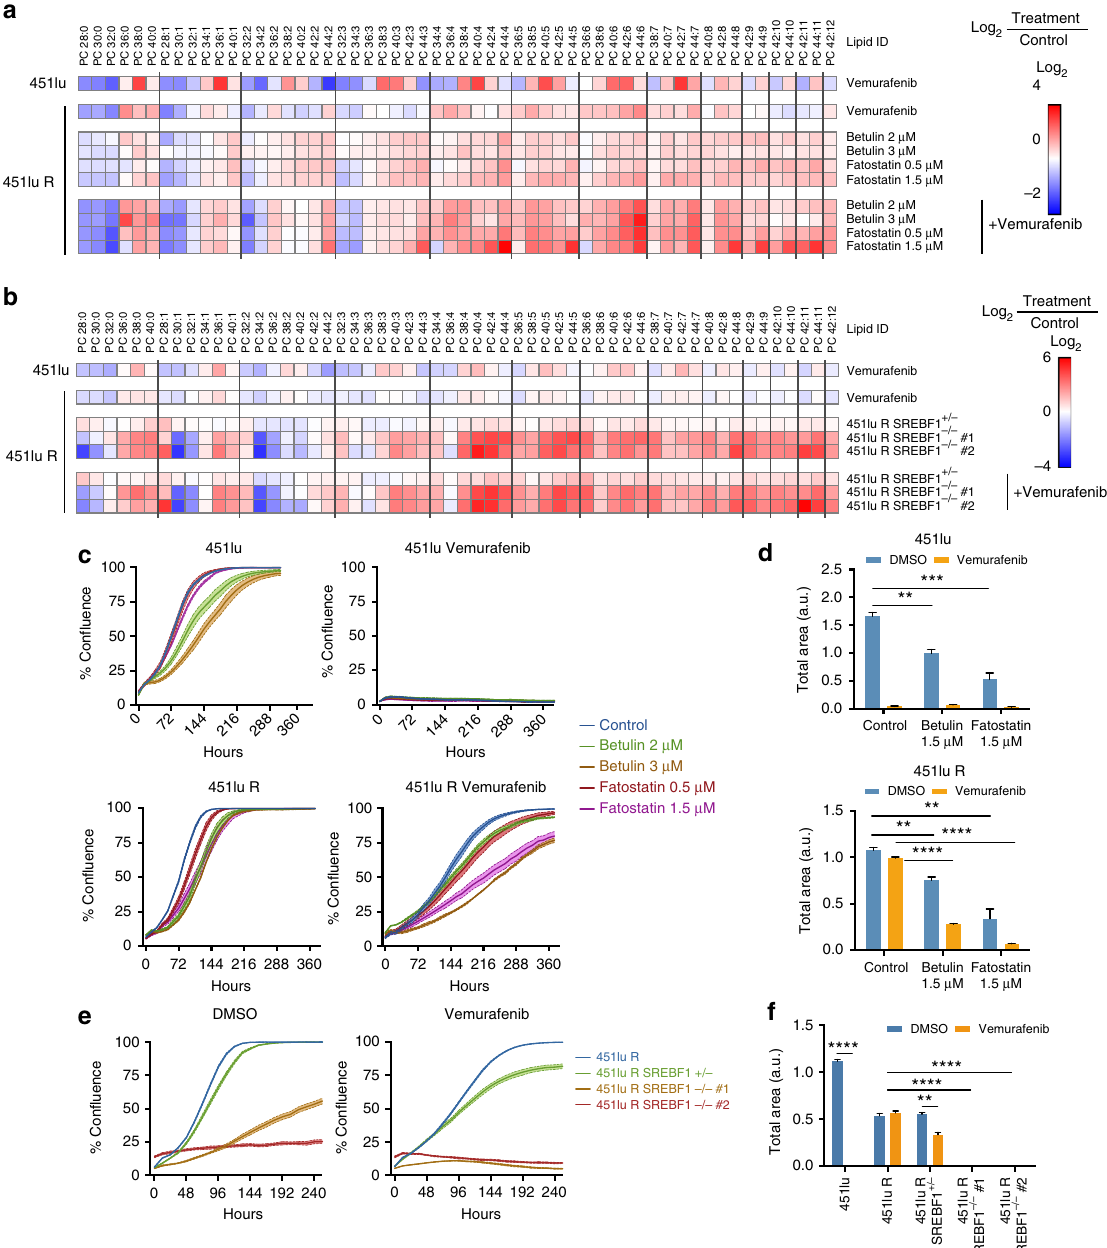
Fig. 3 SREBP-1 contributes to membrane saturation and therapy resistance. a Lipidomic (phosphatidylcholine) pro fi les of 451lu and 451lu R cells treated with vemurafenib (5 μ M) and SREBP inhibitors fatostatin and betulin ( n = 3). b Lipidomics of hetero- and homozygous CRISPR-Cas9 knockouts of SREBF-1 in combination with vemurafenib treatment ( n = 3). c Proliferation curves of 451lu and 451lu R cells treated with vemurafenib and fatostatin or betulin (phase contrast density measured by the Incucyte system, raw images and bar graph are shown in Supplementary Figs. 10, 11) ( n = 4). d 451lu and 451lu R cells were treated with SREBP inhibitors and vemurafenib and were assayed for their ability to form colonies in soft agar, raw images and bar graph are shown in Supplementary Fig. 12 ( n = 3). e Proliferation curves of 451lu R SREBP KO cells, raw images and bar graph are shown in Supplementary Figs. 13, 14 ( n = 4). f SREBF-1 KO 451lu R cells were assayed for their ability to form colonies in soft agar in presence or absence of vemurafenib, raw images and bar graph are shown in Supplementary Fig. 15 ( n = 3). All data are represented as mean ± s.e.m. (* p < 0.05, ** p < 0.01, *** p < 0.001, **** p <